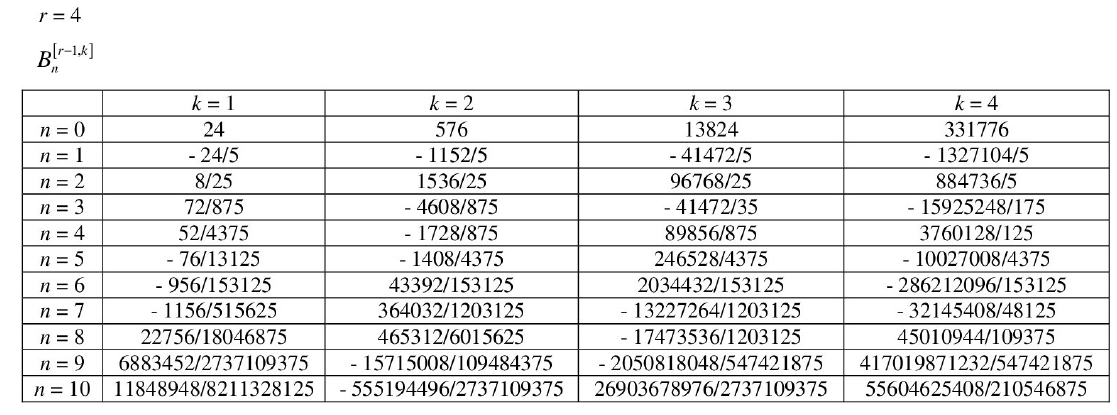
[ 3, k ] = 1,2,3,4; n = 0,1, . . . ,10. n ; k